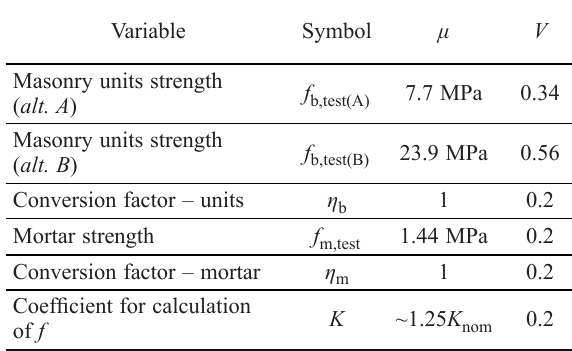
Table 2. Statistical characteristics of variables affecting masonry strength Variable